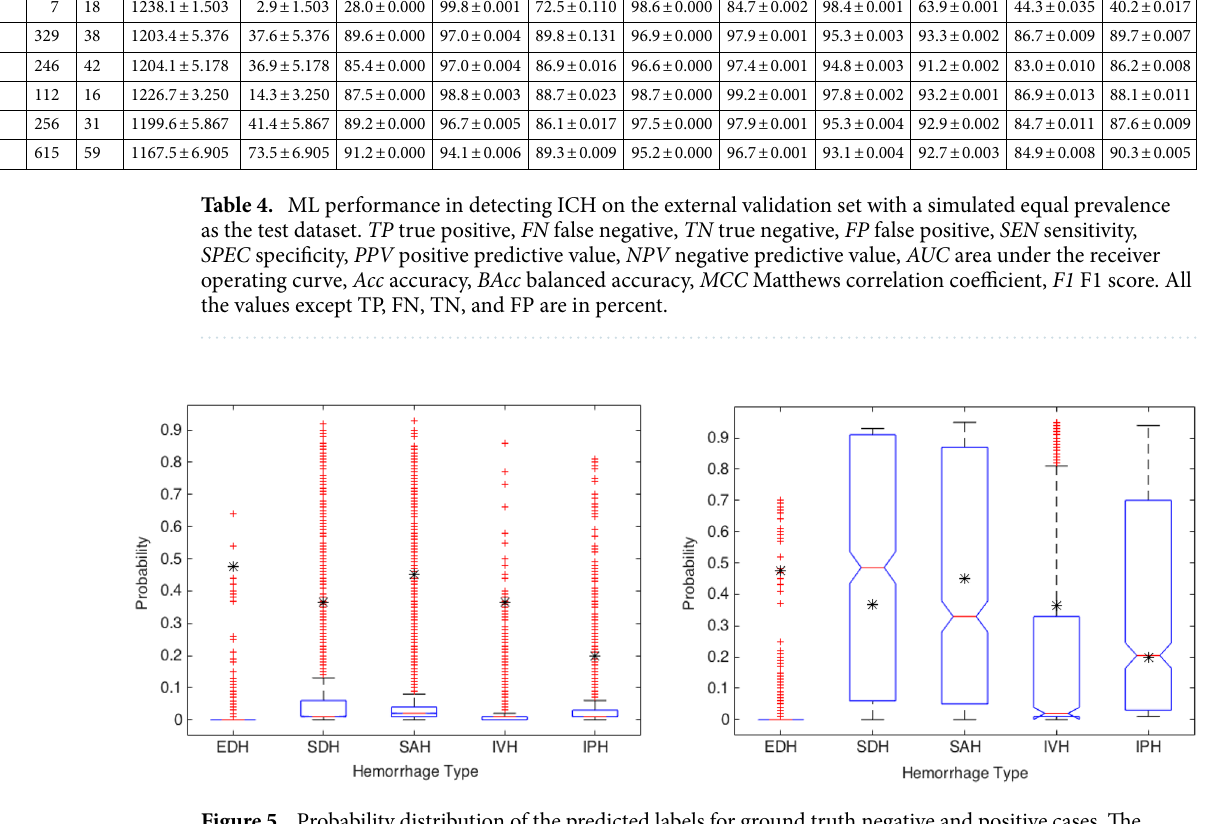
Figure 5. Probability distribution of the predicted labels for ground truth negative and positive cases. The central red line indicates the median, the bottom and top edges of the box indicate the 25th and 75th percentiles, respectively, and the whiskers extend to the most extreme data points not considered outliers. The outliers are plotted individually using the red “+’’ symbol and the found threshold by Bayesian optimizer is plotted using the black “*” symbol. Cases with a probability higher than the threshold are counted toward the corresponding positive and negative